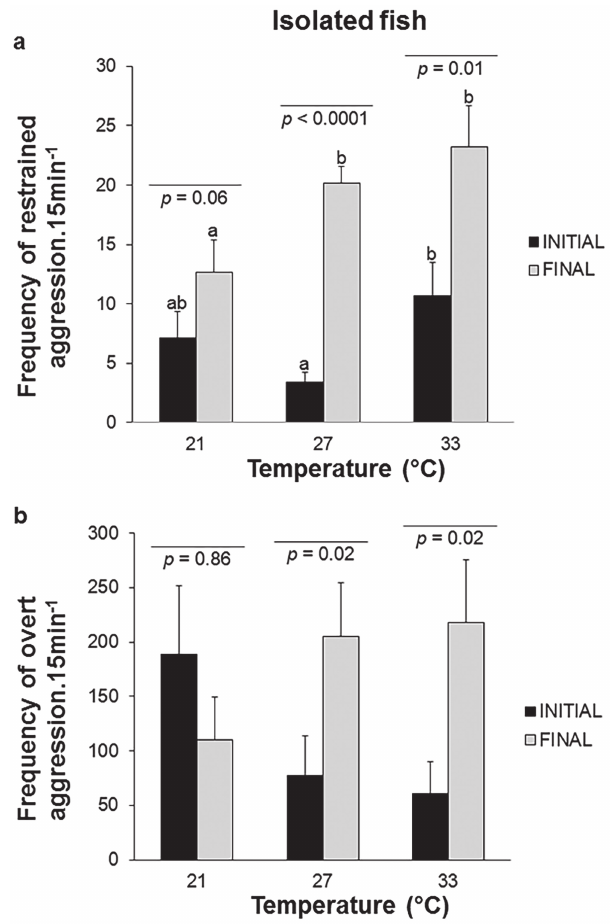
Fig. 2. Mean ± SE of initial (third day) and final (eighth day) frequencies of a. restrained aggression and b. overt aggression of isolated fish against the mirror for Cichlasoma paranaense .